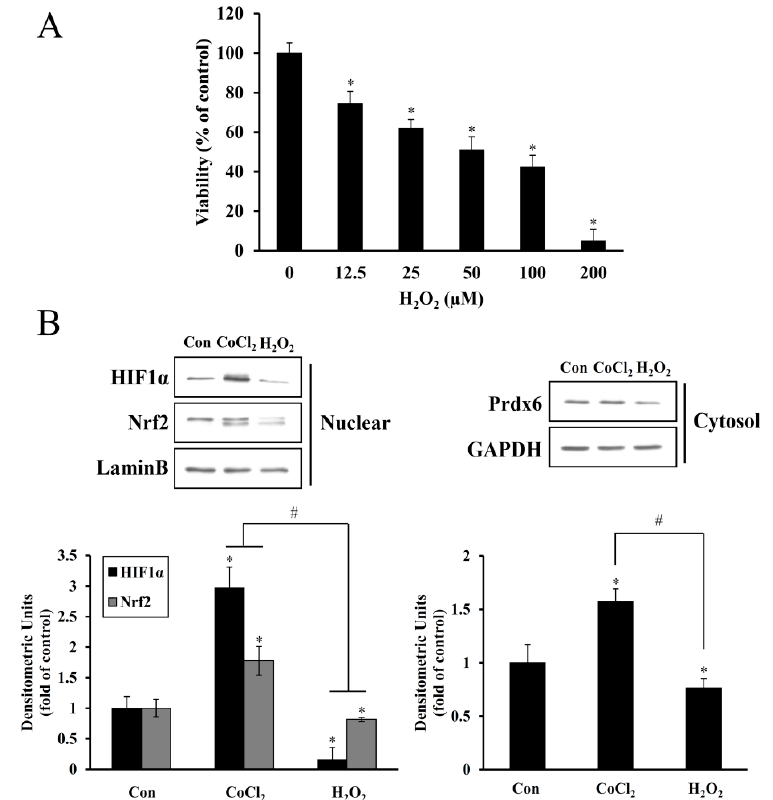
Figure 3. Inhibitory effect of H 2 O 2 on HEI-OC1 cell viability and HIF-1 α , NRF-2, and Prdx6 expression. ( A ) After exposure to 0–200 μ M H 2 O 2 for 24 h, cell viability was determined using the